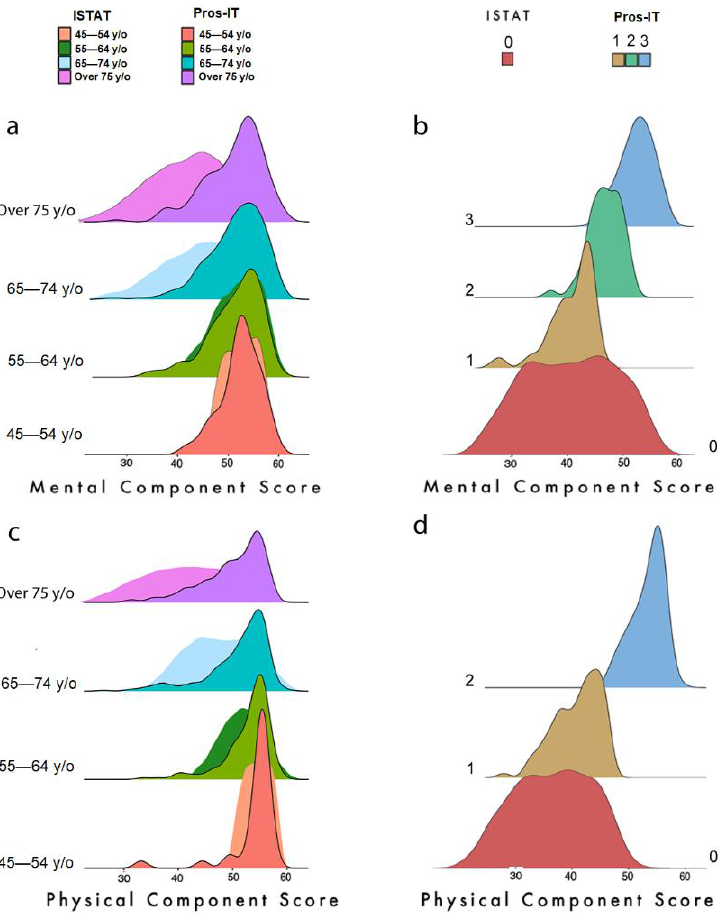
Figure 4. ( a ) Distribution of MCS scores of the Pros-IT and ISTAT populations according to age groups; ( b ) Distribution of MCS scores in trajectories for Pros-IT participants and of the ISTAT cancer patients; ( c ) Distribution of PCS scores of the Pros-IT and ISTAT populations according to age groups; ( d ) Distribution of PCS scores in trajectories for Pros-IT participants and of the ISTAT cancer patients.